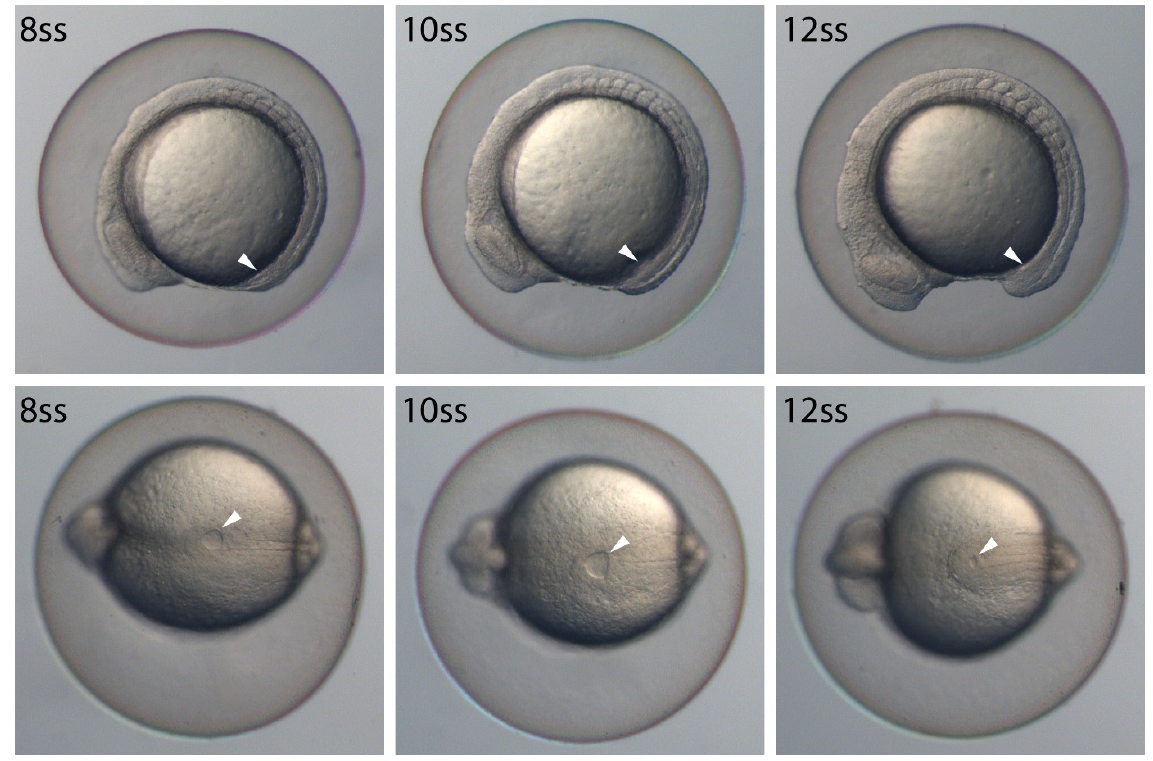
Figure 2. Kupffer’s vesicle changes significantly in a short developmental window. Lateral (top panels) and ventral (bottom panels) views of zebrafish from the 8 somite stage (ss) to the 12 ss. Over this developmental window, Kupffer’s vesicle (white arrowhead) expands and then shrinks, reaching its greatest size at the 10 ss. At 28.5°C, zebrafish will form approximately two somites per hour, so the above panels represent a 4-hour